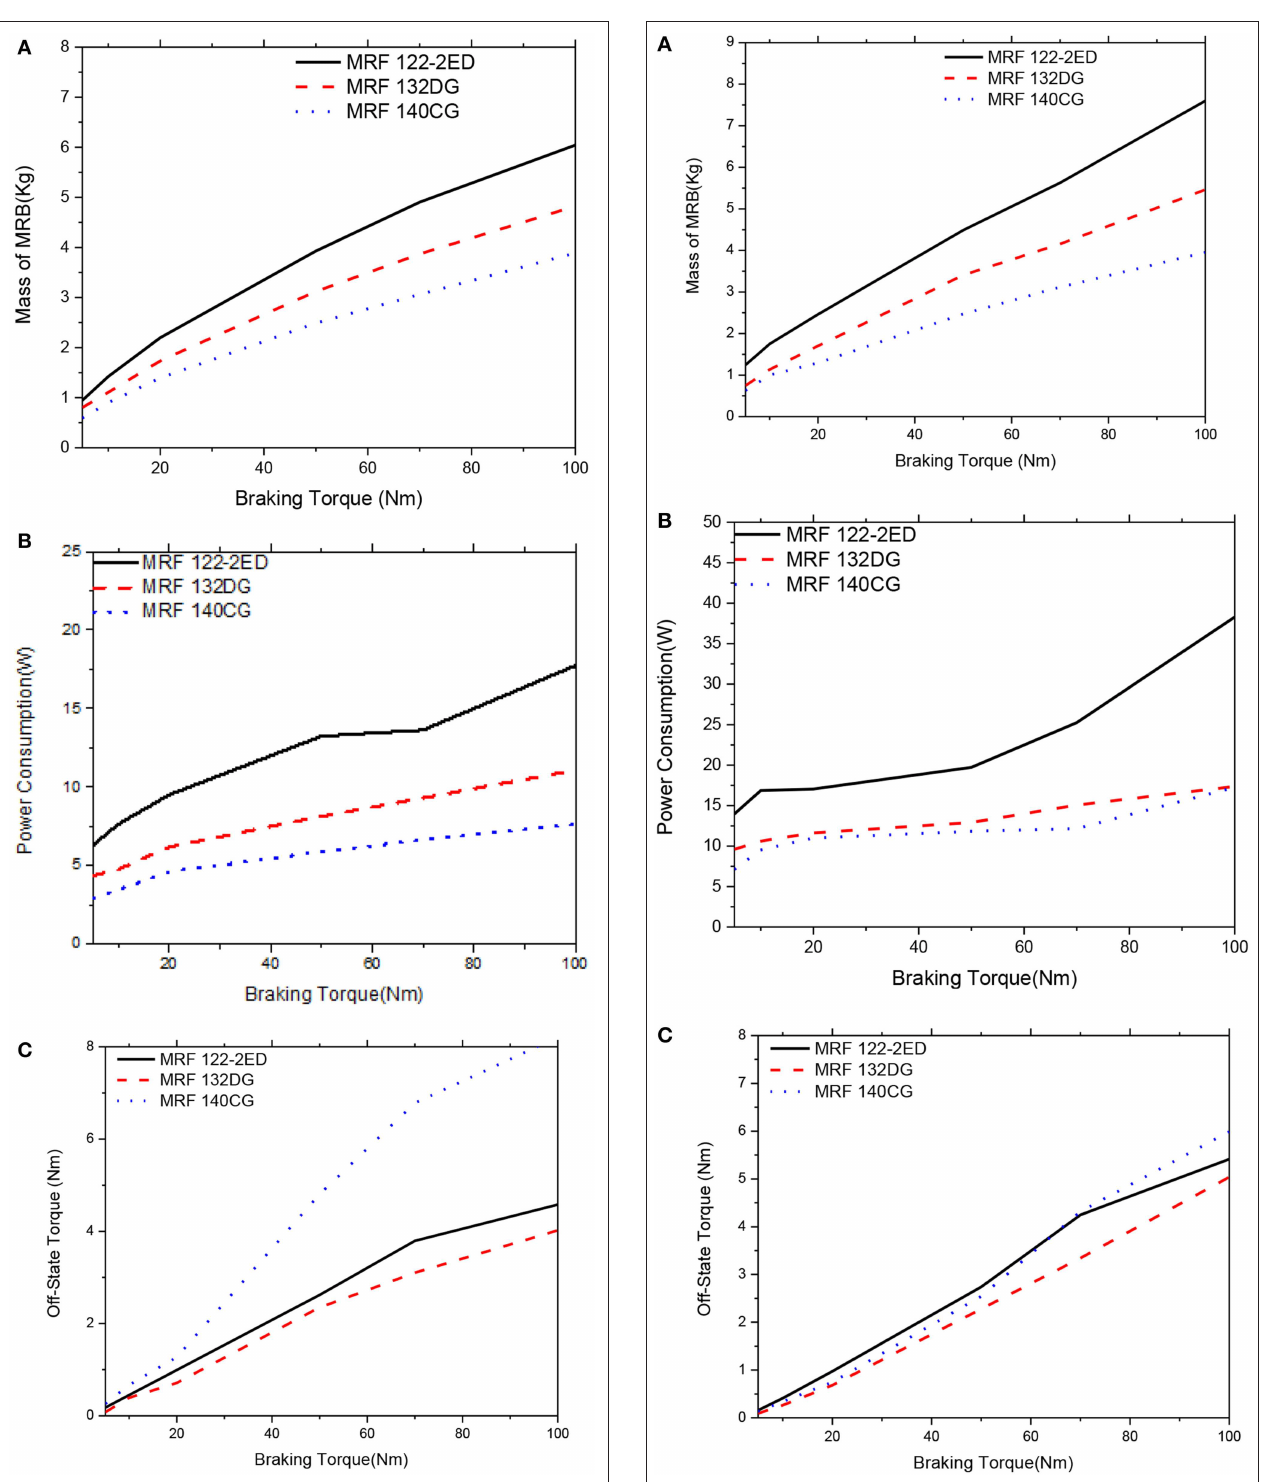
Frontiers in Materials | www.frontiersin.org